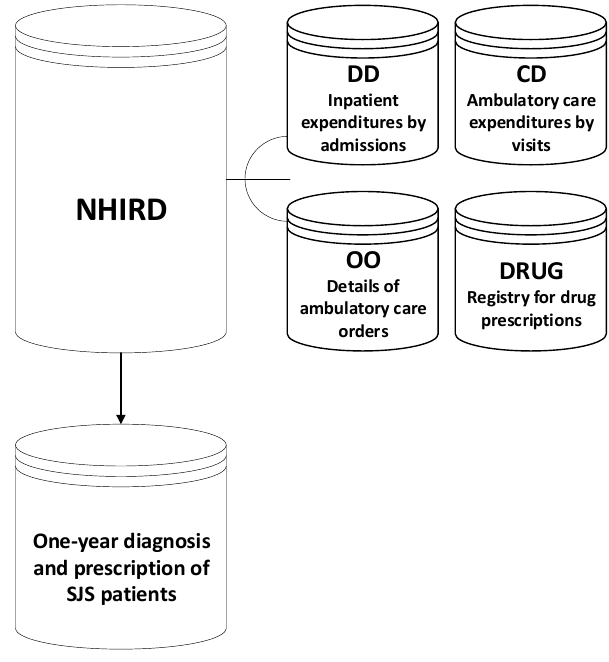
Figure 2. Data collection.